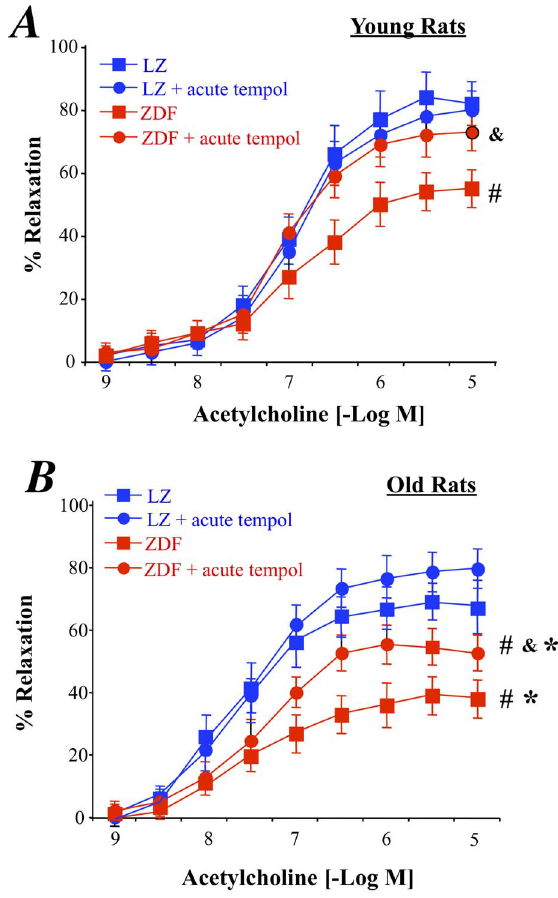
Figure 3. Effect of the acute treatment of mesenteric resistance arteries with the antioxydant tempol on acetylcholine-induced relaxation in mesenteric resistance arteries isolated from young (A) and old (B) LZ and ZDF rats. Mean 6 SEM is presented (n=10 per group). # P , 0.01, ZDF versus LZ. *P , 0.01, old versus young rats. &P , 0.05, effect of tempol on acetylcholine-induced relaxation.